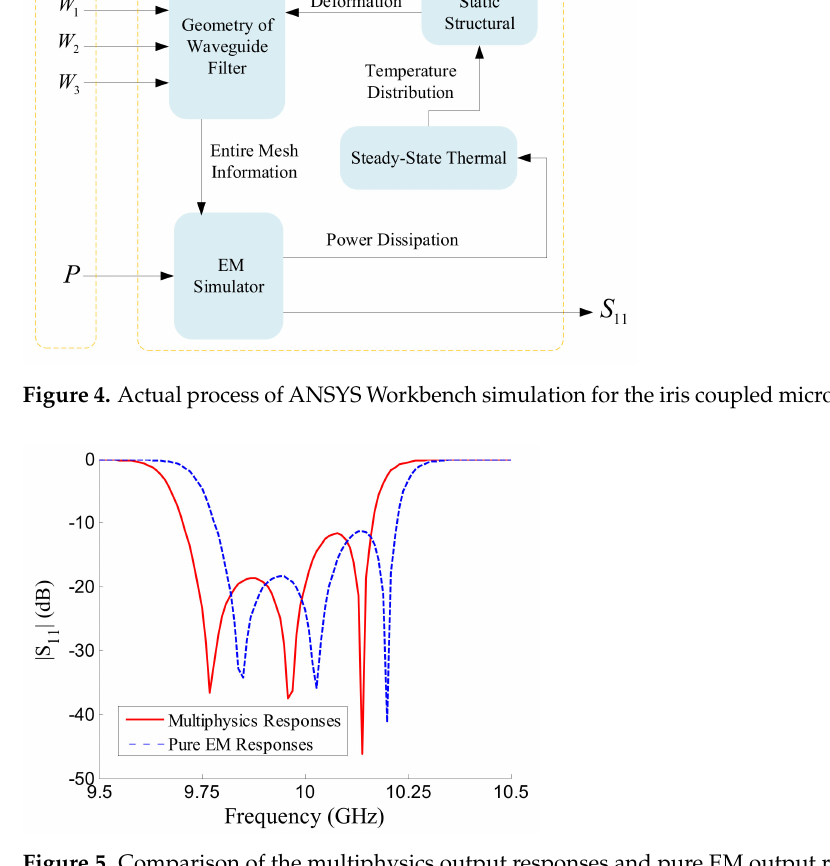
Figure 5. Comparison of the multiphysics output responses and pure EM output responses with the same geometrical parameters for the iris coupled microwave cavity